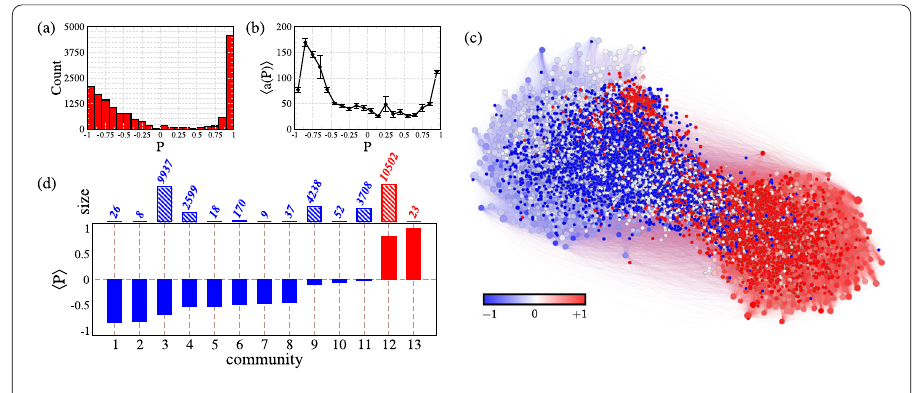
Figure 1 ( a ) Number of users as a function of the political position P . ( b ) Average activity as a function of P . Only users with activity a ≥ 10 in the SCC are considered for ( a ) and ( b ). ( c ) Visualization of the time-aggregated representation of the PC network, formed by N = 31,412 users in the SCC. The size of nodes increases (non-linearly) with their degree. Colors represent political position, as defined by (1), blue for pro-, red for anti-impeachment, and white for neutral average leaning. ( d ) Community size and average political position of different communities identified by the Louvain